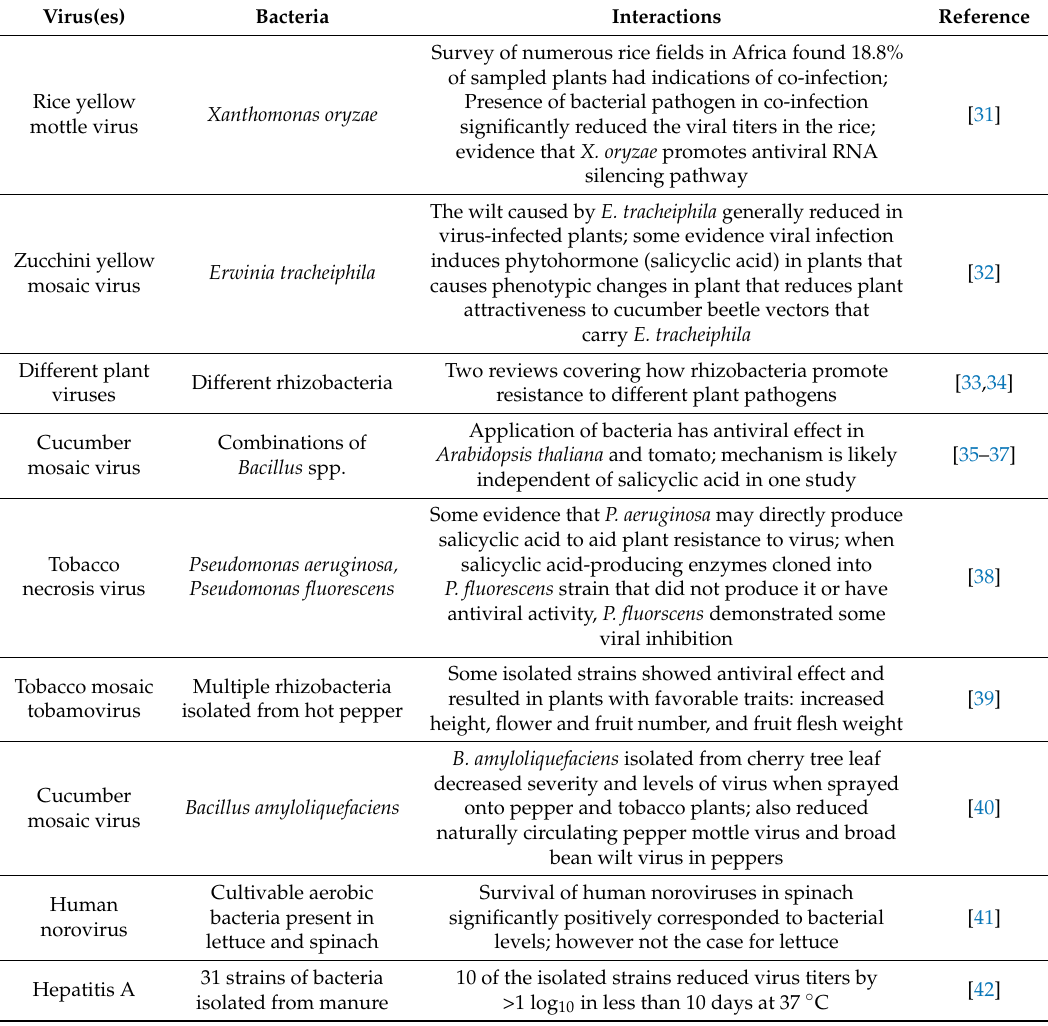
Table 2. Selected reports of eukaryotic virus–bacteria interactions in the horticultural